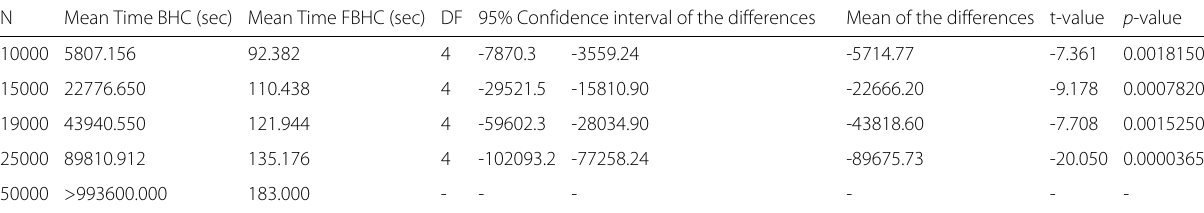
Table 4 Statistical evaluation of the computational time of the FBHC method compared to the BHC